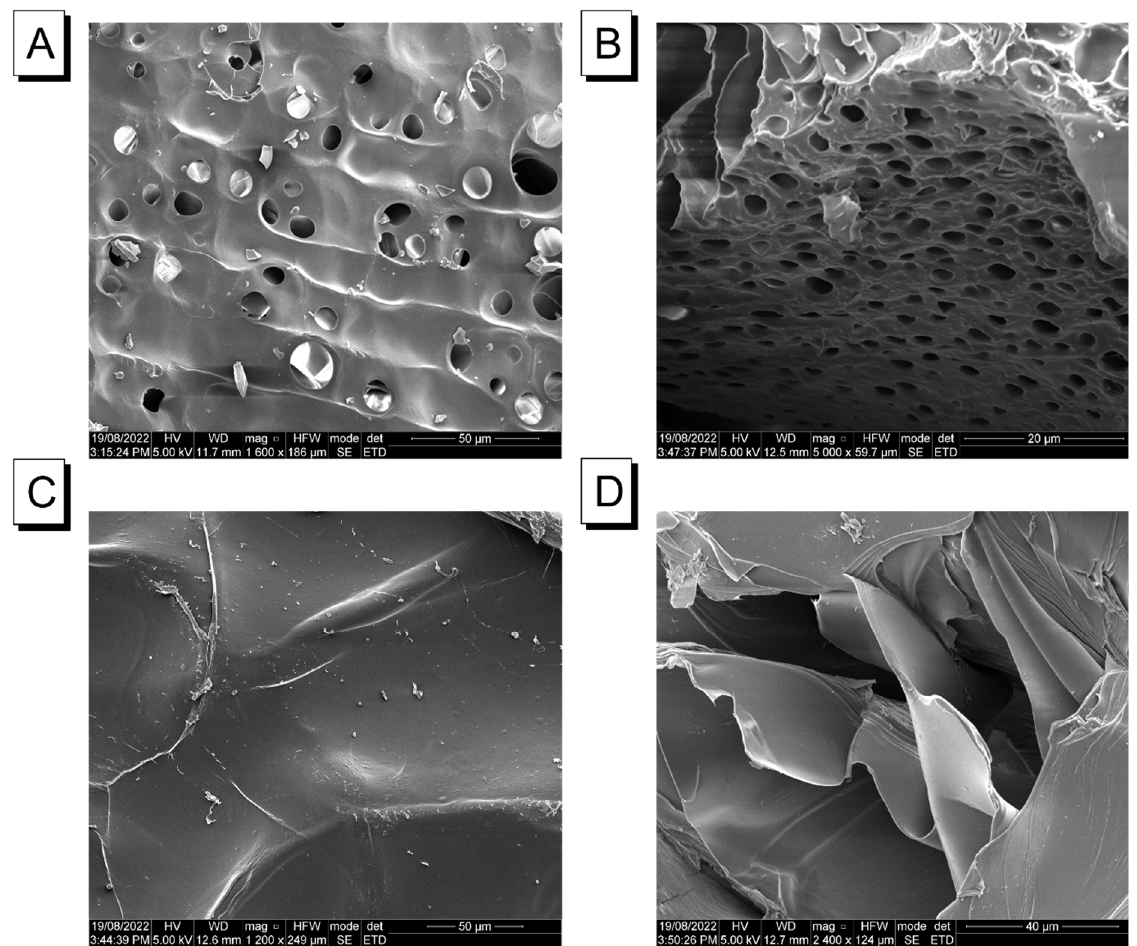
Figure 3 . SEM images captured under 50 μ m magnification from the surface of an ( A ) AAm–Alg + TC426 hydrogel film, ( C ) carrageenan + TC426 hydrogel film. SEM images captured under magnification 20 and 40 μ m from the cross section of ( B ) AAm–Alg + TC426 hydrogel film, and ( D ) carrageenan + TC426 hydrogel film.